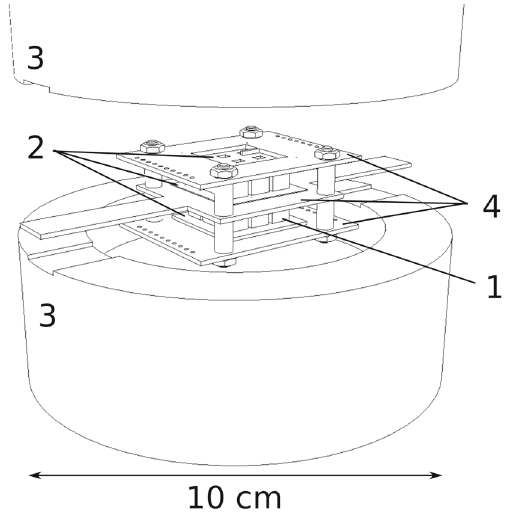
Fig. 8 3D sketch of the NUCLEUS-10g detector. It consists of three different types of cryogenic calorimeters – two 3 × 3 arrays of gram- scale cryogenic calorimeters as CE ν NS target (1), an inner veto (2) and an outer veto (3) with a diameter of 10cm. The assembly is held mechanically by a non-instrumented support structure (4). The target is operated in anti-coincidence with the inner and the outer veto. See text for